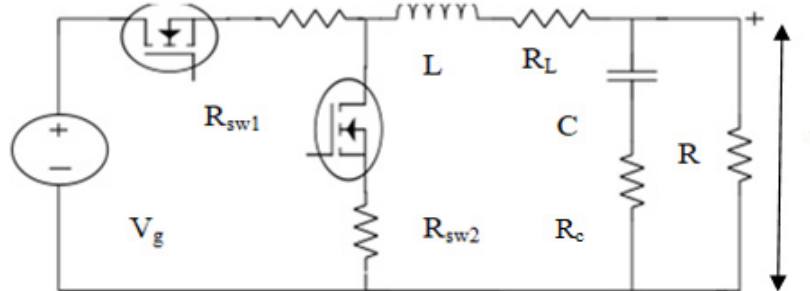
Figure 4. Schematic of the converter.